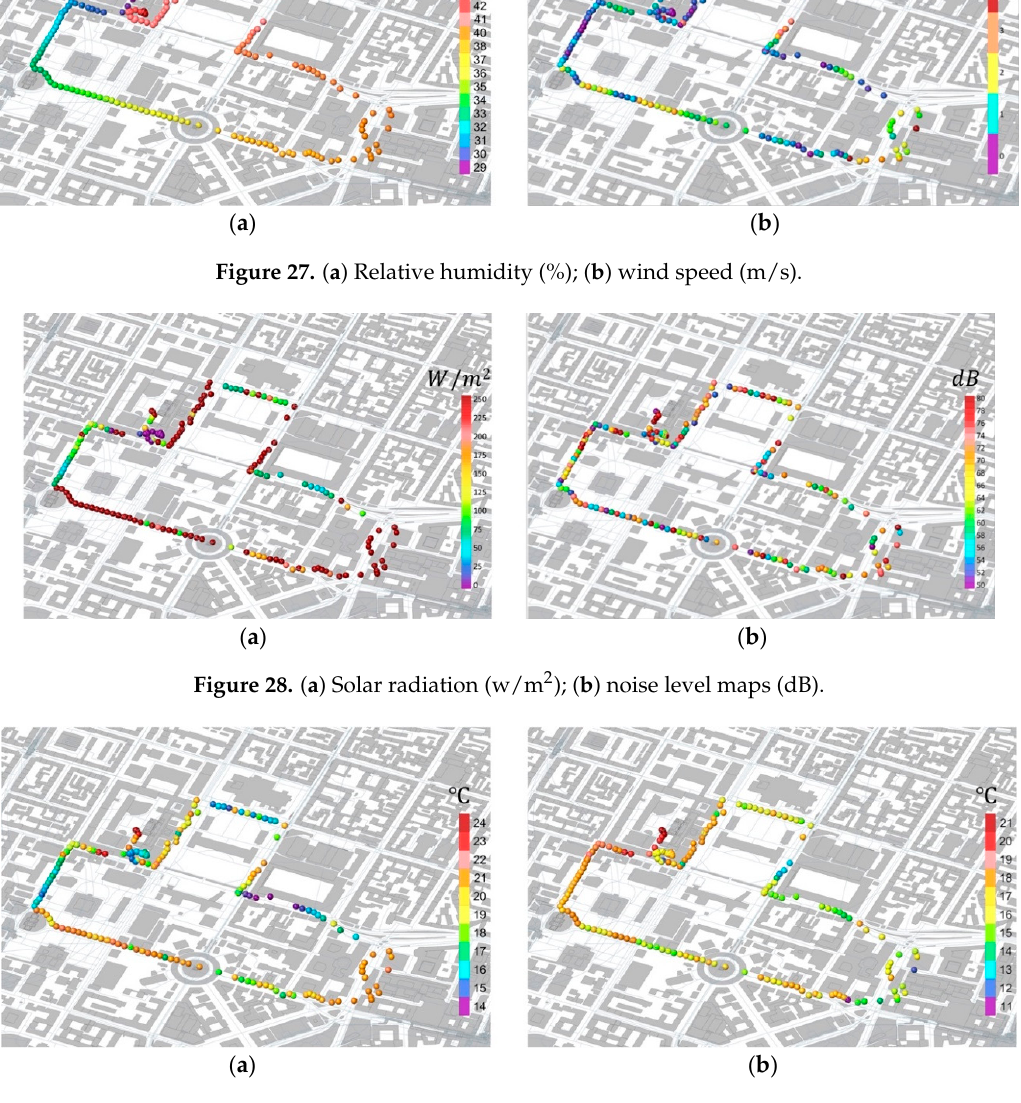
Figure 29. ( a ) Mean radiant temperature (°C); ( b ) universal thermal climate index maps (°C).